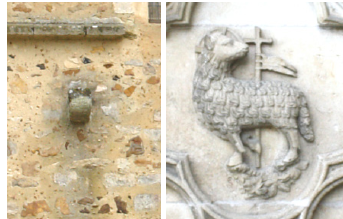
Figure 3. On the left: hook and dripstone as evidence of the former cloister. On the right: the monastery’s